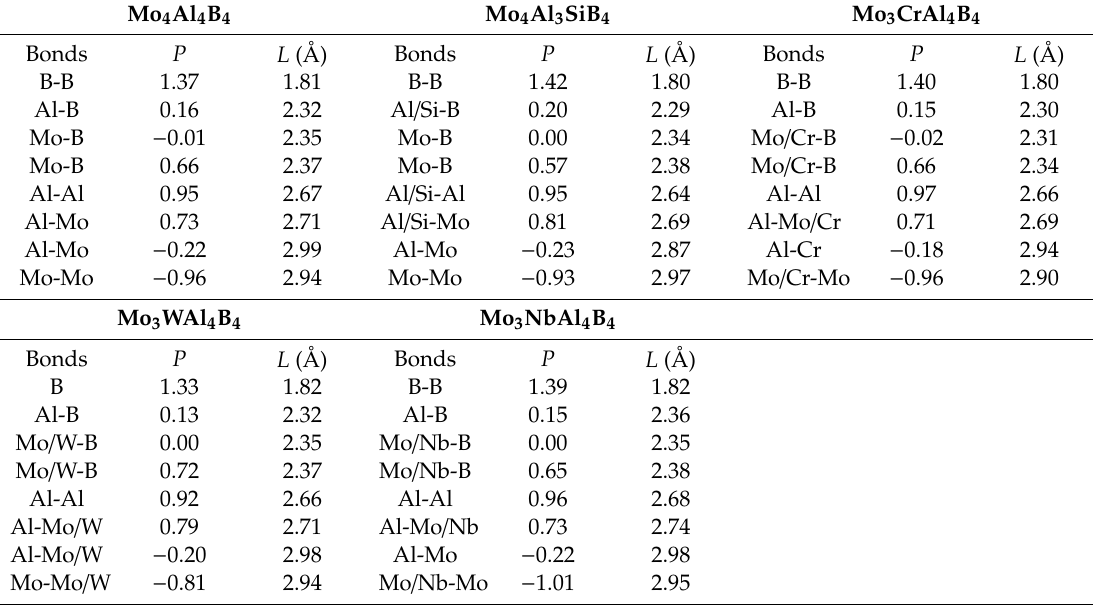
Table 5. The calculated bond lengths and overlapped populations ( P (dimensionless) and L (Å) representing the population and bond length,